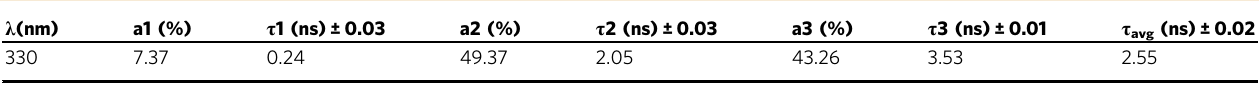
The average lifetime τ avg was obtained by (a1 τ 1 + a2 τ 2 + a3 τ fi tted to a tri-exponential decay curve (Fig. 3d, Supplementary Fig. S14a). The tri-exponential fi t parameters obtained from fl uorescence spectroscopy included three lifetime values (Table 1). The 0.24 ns component with a small fractional amplitude of ∼ 7% showed ultrafast decay, while the other two components (2.05 ns and 3.53 ns) had fractional amplitude of 49